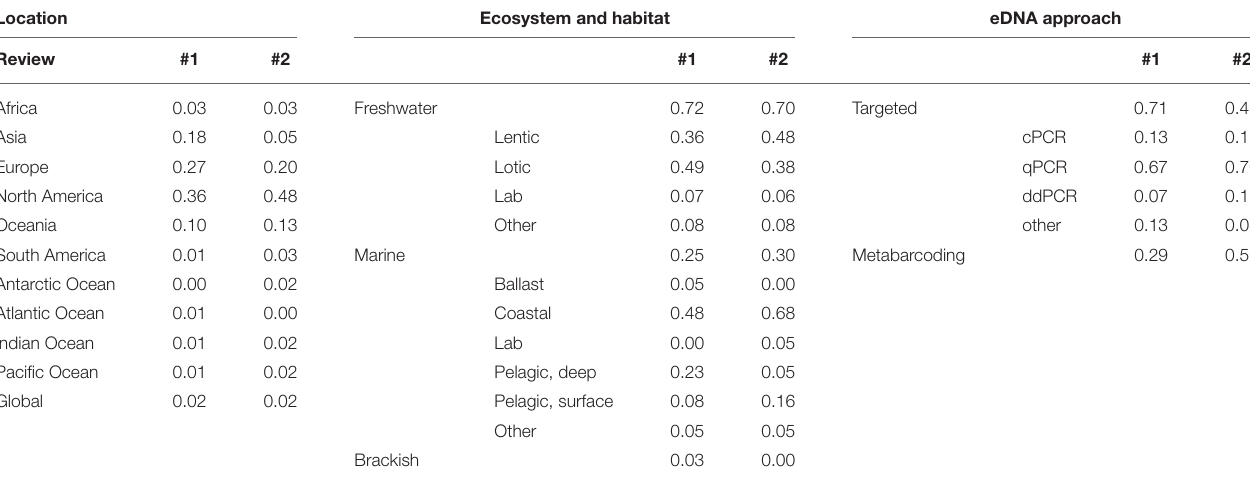
TABLE 2 | The proportion of studies in Literature Review #1 ( N = 155) and #2 ( N = 62) by geographic location, ecosystem and habitat, and eDNA approach. Location Ecosystem and habitat eDNA